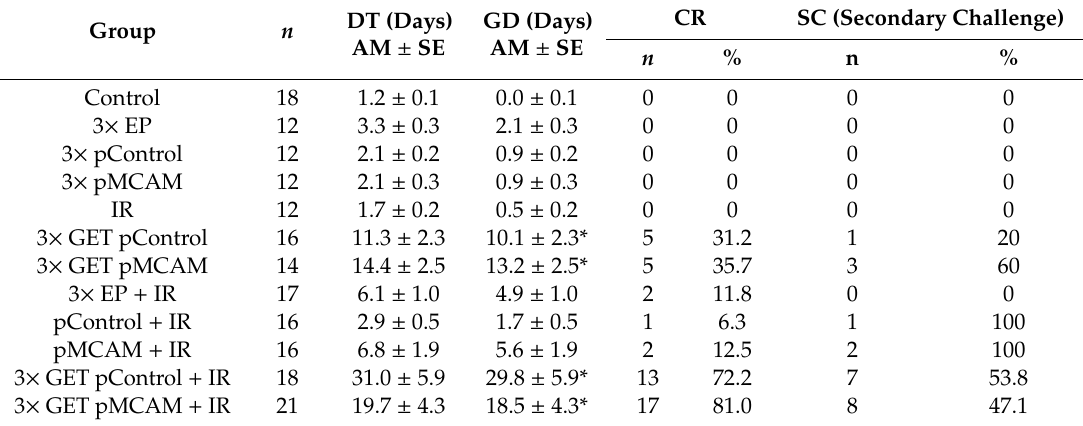
Table 1. The antitumor response of B16F10 melanoma after di ff erent treatment modalities. Group n DT (Days) AM ±